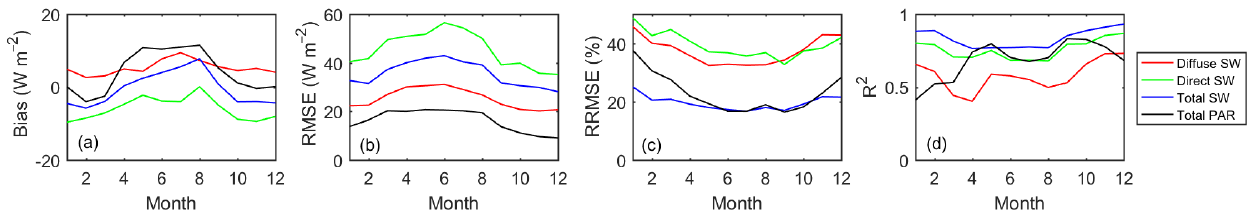
Figure 6. Evaluation of EPIC-based daily SW–PAR estimates for different months during the study